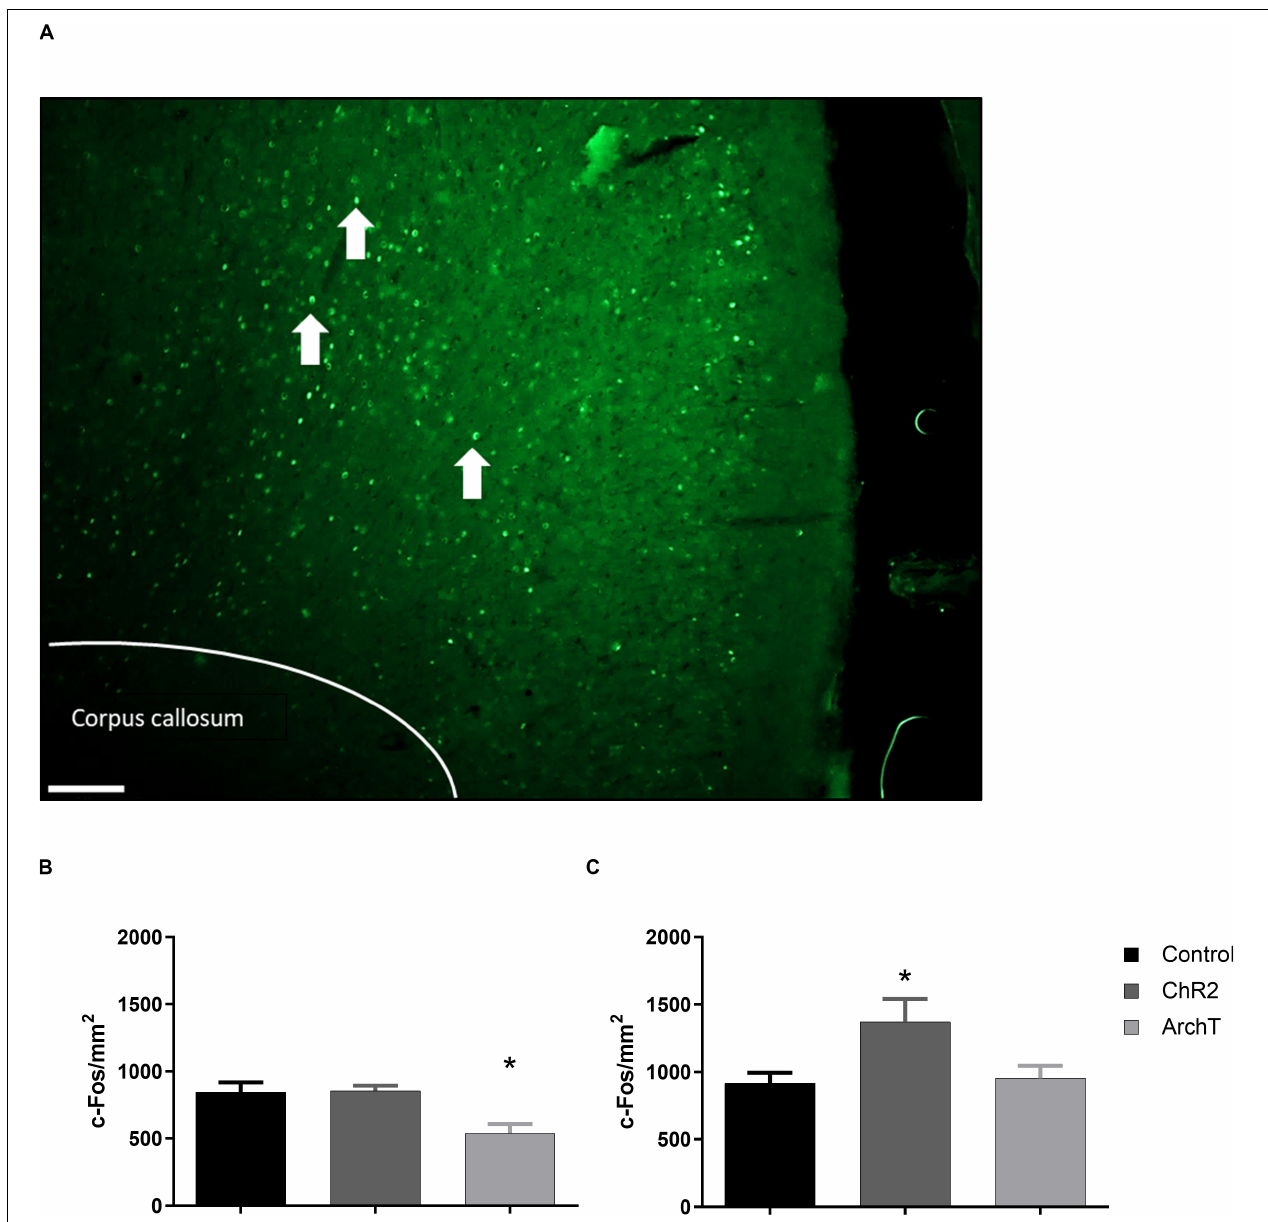
FIGURE 5 | Effects of optogenetic stimulation (ChR2) or inhibition (ArchT) of glutamatergic neurons in the ACC on c-Fos positive cells in the ACC of SD rats. (A) Representative images of c-Fos (green) expression within the ACC (scale bar = 200 µ m). White arrows denote representative c-Fos-positive staining. (B) Effects of optogenetic stimulation (ChR2) or inhibition (ArchT) of glutamatergic neurons in the ACC on c-Fos positive cells in the ACC of male SD rats. Data are mean ± SEM ( n = 5–6 per group). * p < 0.05 vs. control. (C) Effects of optogenetic stimulation (ChR2) or inhibition (ArchT) of glutamatergic neurons in the ACC on percent of c-Fos positive cells in the ACC of female SD rats. Data are mean ± SEM ( n = 4–6 per group). * p < 0.05 vs.